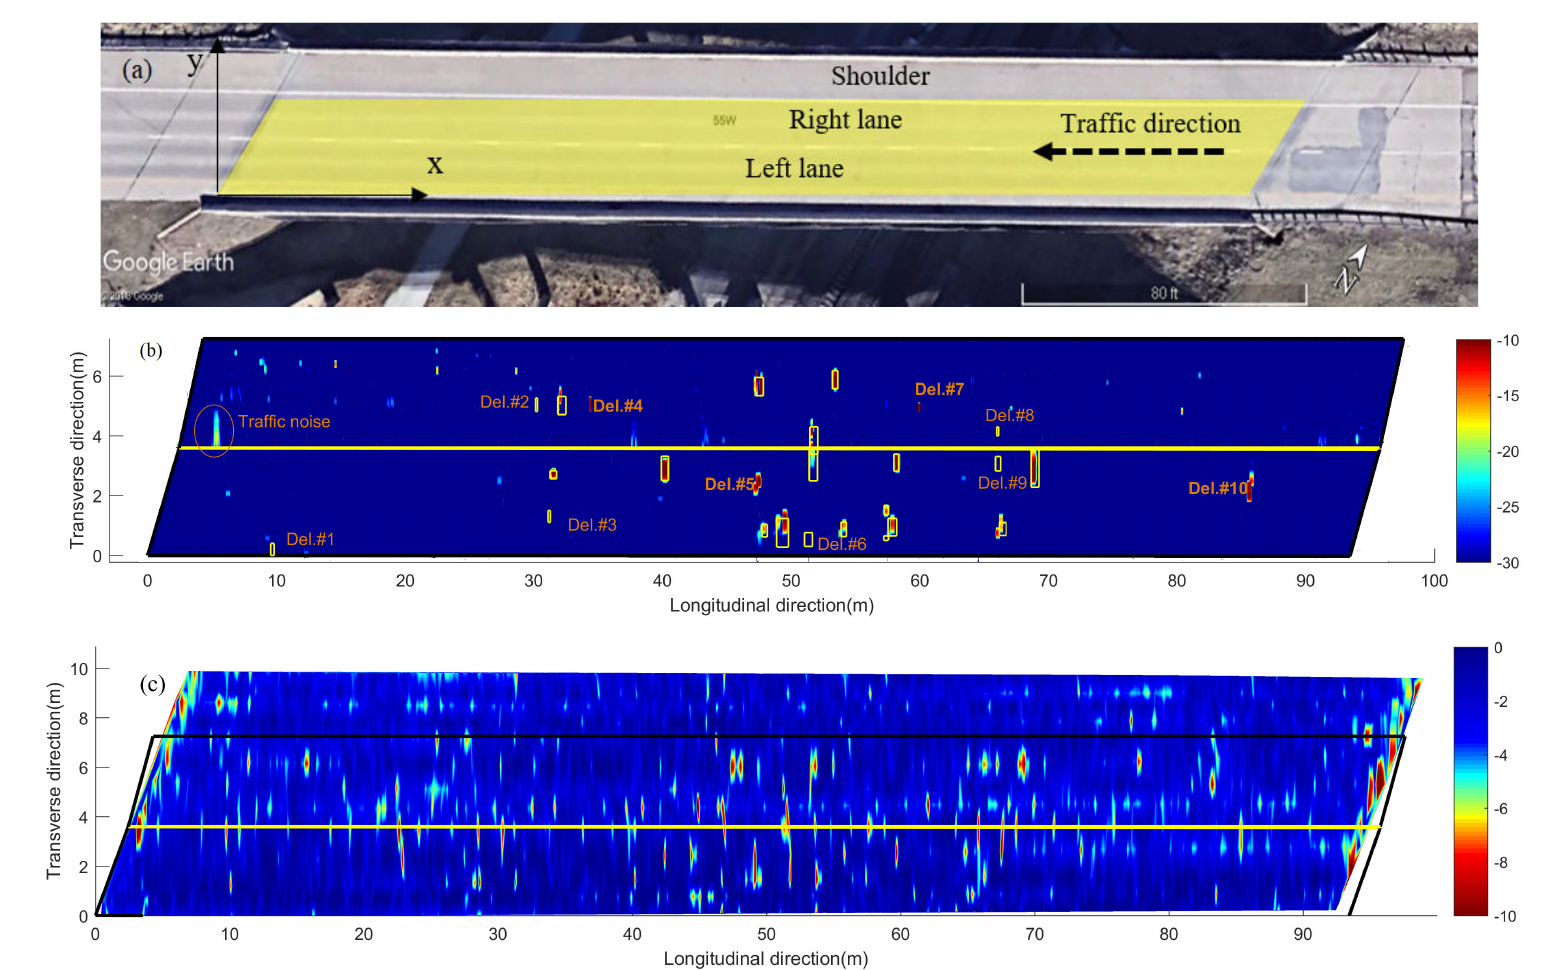
Figure 8. Straight concrete bridge deck: ( a ) Google Earth image; ( b ) acoustic scanning image; ( c ) GPR attenuation